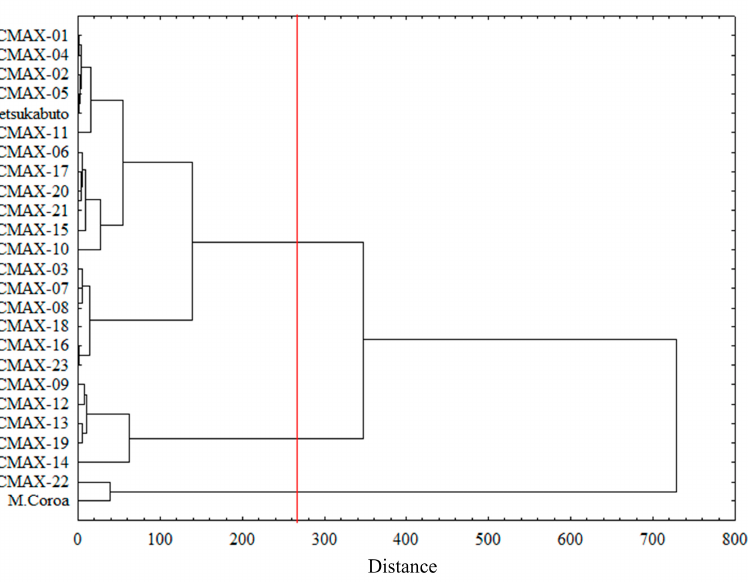
Figure 3. Dendrogram of the genetic divergence of 23 accessions and 2 commercial cultivars of Cucurbita maxima based on color traits, total carotenoids, and β -carotene. Mossoró, 2020.